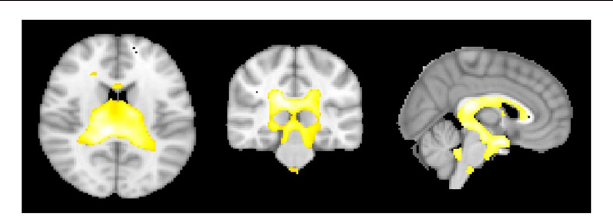
FIGURE 5 | The areas showing that as age increases there is a significant increase in gray matter volume at the cerebrospinal fluid (CSF) boundaries for the regression group of all subjects using age as the regressor of